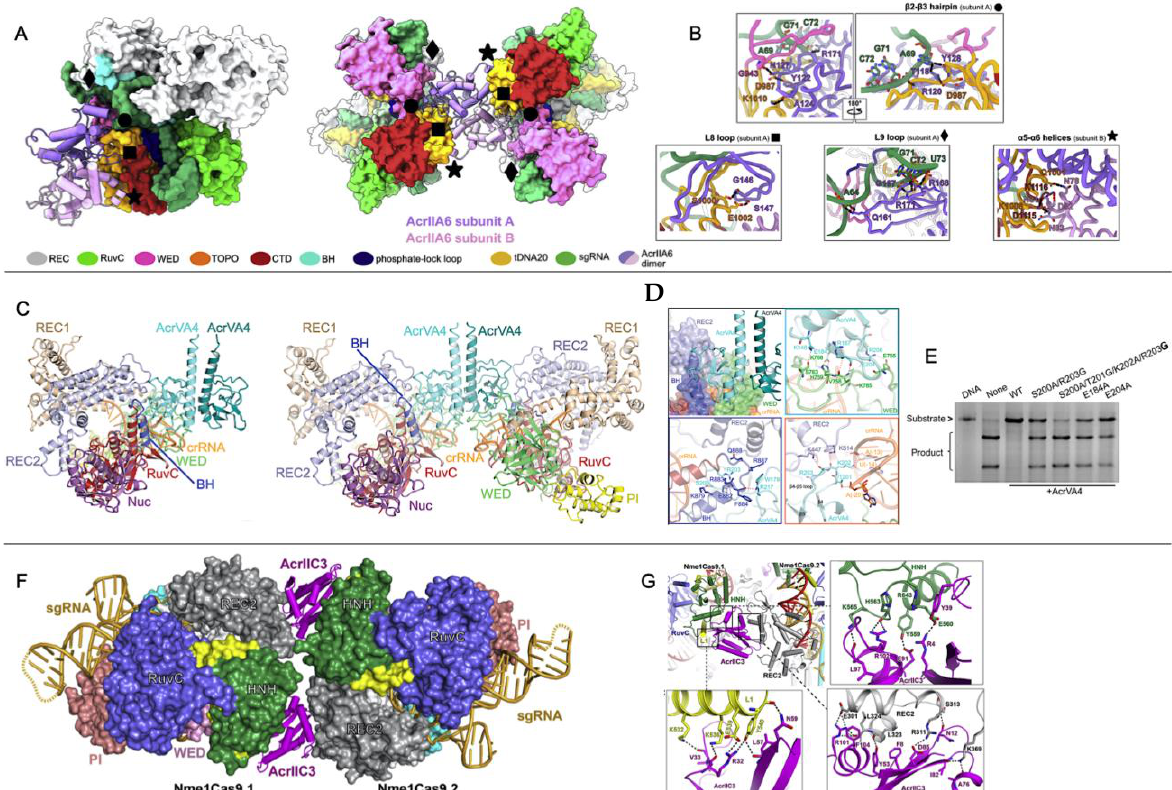
Figure 5. Acr-driven oligomerization of Cas proteins ( A ) Domain-specific interactions of the AcrIIA6 dimer (purple/pink) with St1 Cas9. AcrIIA6 allosterically inhibits the St1 Cas9 monomer (left) or dimer (right) via intermolecular interactions at sites noted by black diamonds, circles, squares, and stars. ( B ) Close-up views of the AcrIIA6 interactions at selected sites within the St1 Cas9-sgRNA complex. ( C ) Cryo-EM structures of AcrVA4 dimer in complex with one copy (left) or two copies (right) of Lb Cas12a-crRNA. ( D ) Close up views on AcrVA4 interactions with REC2, WED domain, the bridge helix (BH), and the crRNA. ( E ) An in vitro DNA cleavage assay of Fb Cas12a in the presence of wild-type or mutant AcrVA4 highlights the inability of AcrVA4 to inhibit Lb Cas12a function when BH and cRNA binding residues are mutated. ( F ) Crystal structure of Nme Cas9-gRNA-AcrIIC3 complex showing two Nme Cas9-gRNA complexes bound to one AcrIIC3. ( G ) Close-up views of the interactions between AcrIIC3 and Nme HNH, Nme Rec2, and the L1 linker of Nme Cas9. Figure 5A,B is reprinted/adapted from Fuchsbauer, O. et al. Cas9 allosteric inhibition by the anti-CRISPR protein AcrIIA6 [35]. Figure 5C – E reprinted/adapted from Zhang, H. et al. Structural basis for the inhibition of CRISPR-Cas12a by anti-CRISPR proteins [37]. Figure 5F,G is reprinted/adapted from Sun, W. et al. Structures of Neisseria meningitidis Cas9 complexes in catalytically poised and anti-CRISPR-inhibited states [59].